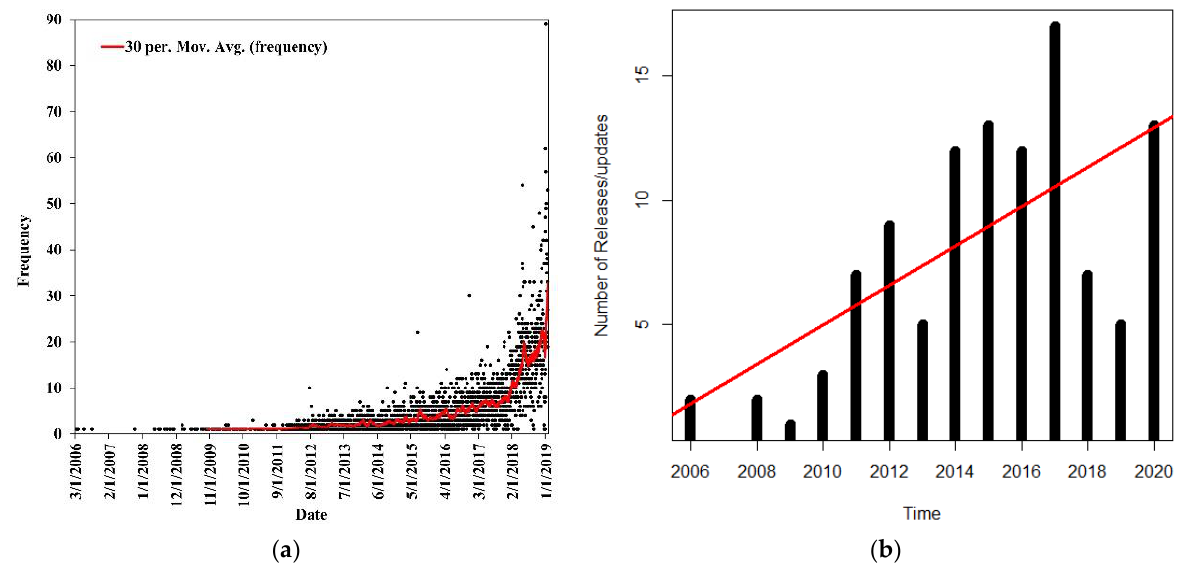
Figure 1. ( a ) The number of R packages released on CRAN in the past 14 years (source: R project website: https://cran.r- project.org/web/packages/available_packages_by_date.html (Accessed on 18 October 2021)); ( b ) the number of R packages developed for hydro-science and engineering.